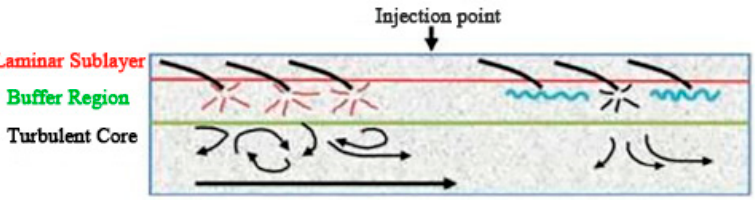
Figure 1. Schematic diagram of turbulent flow in the pipeline [11].